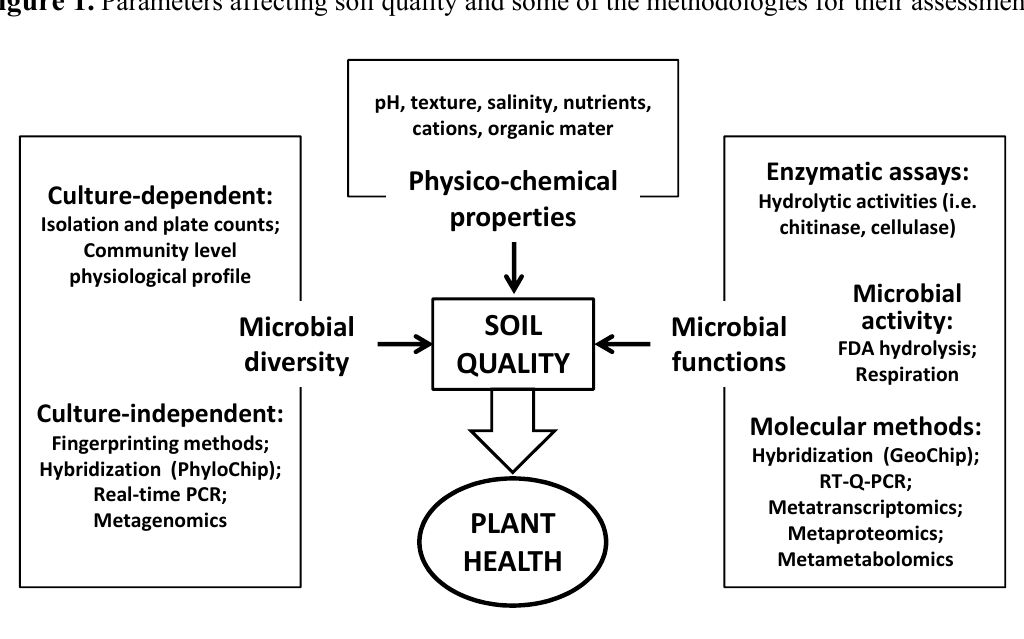
Figure 1. Parameters affecting soil quality and some of the methodologies for their